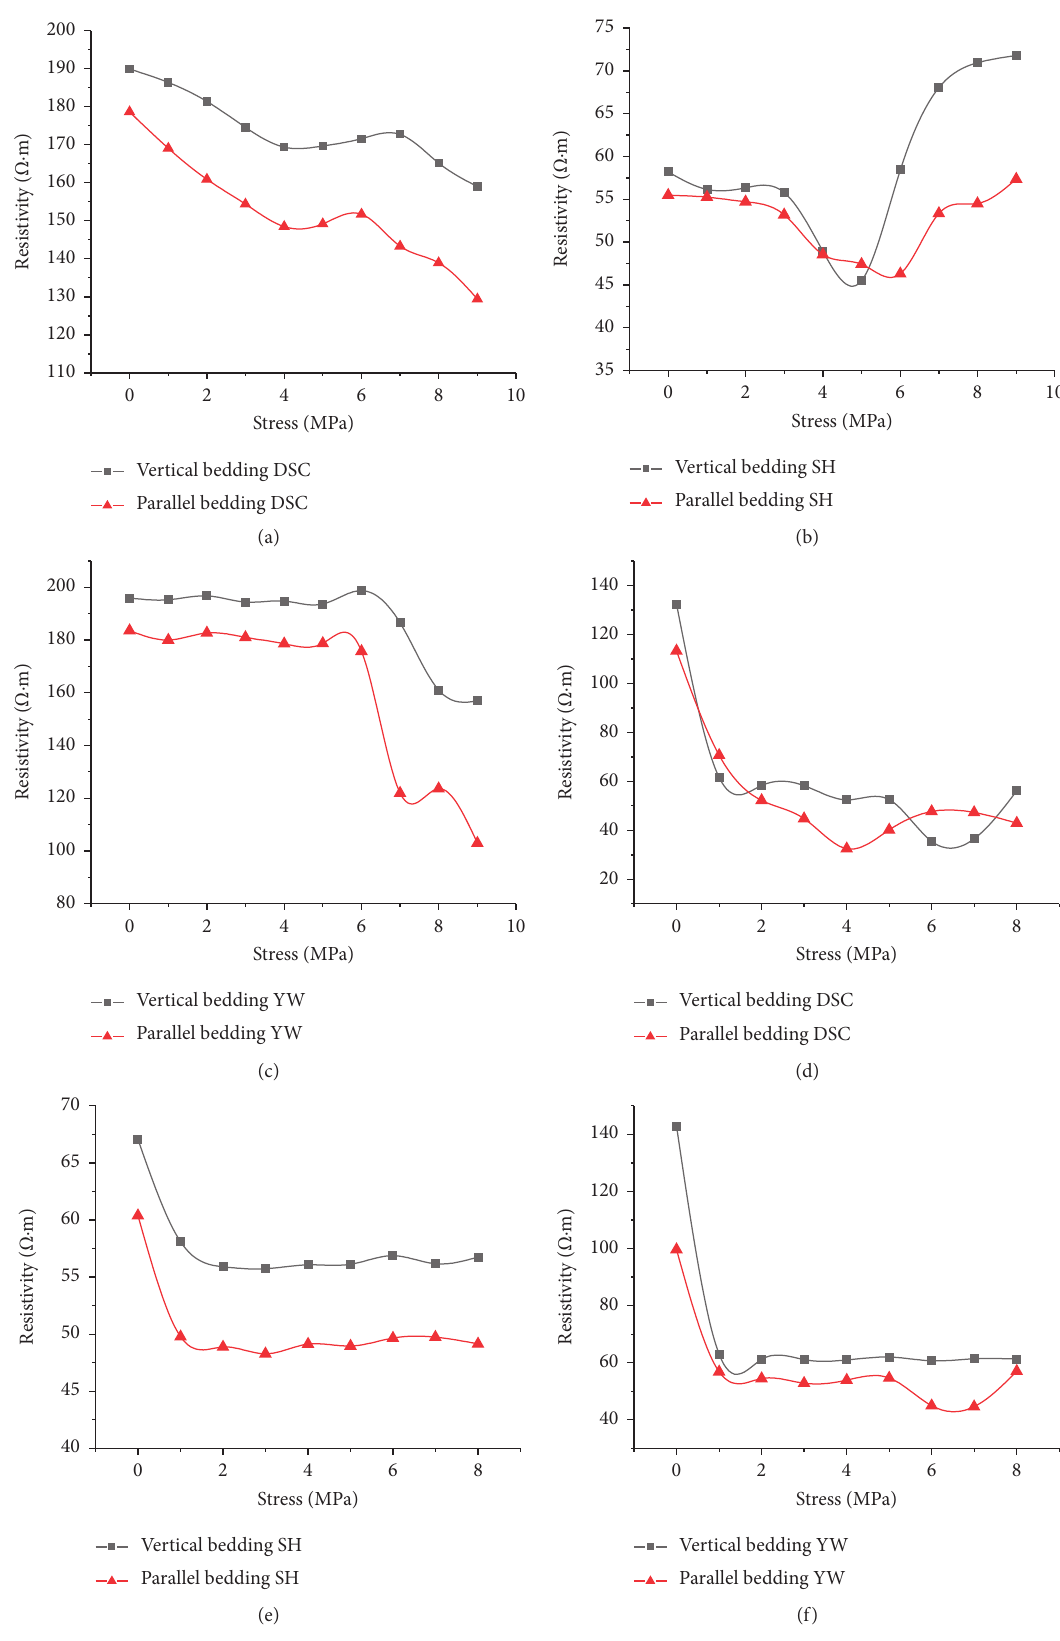
Figure 3: Resistivity curves in different bedding directions. (a) Dashucun coal samples under axial pressure. (b) Sihe coal samples under axial pressure. (c) Yuwu coal samples under axial pressure. (d) Dashucun coal samples under confining pressure. (e) Sihe coal samples under confining pressure. (f) Yuwu coal samples under confining